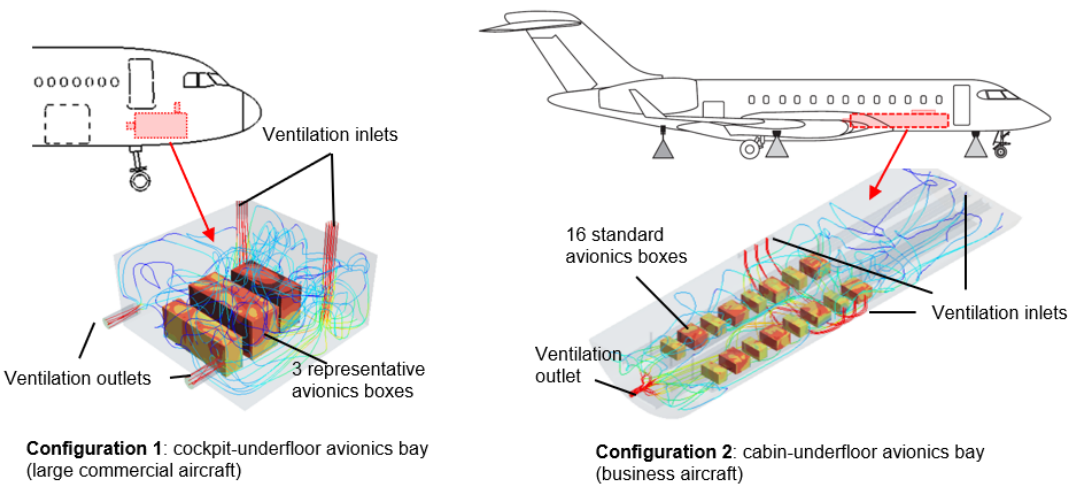
Figure 1. Aircraft avionics bay configurations for the investigation of the thermal radiation aspect.